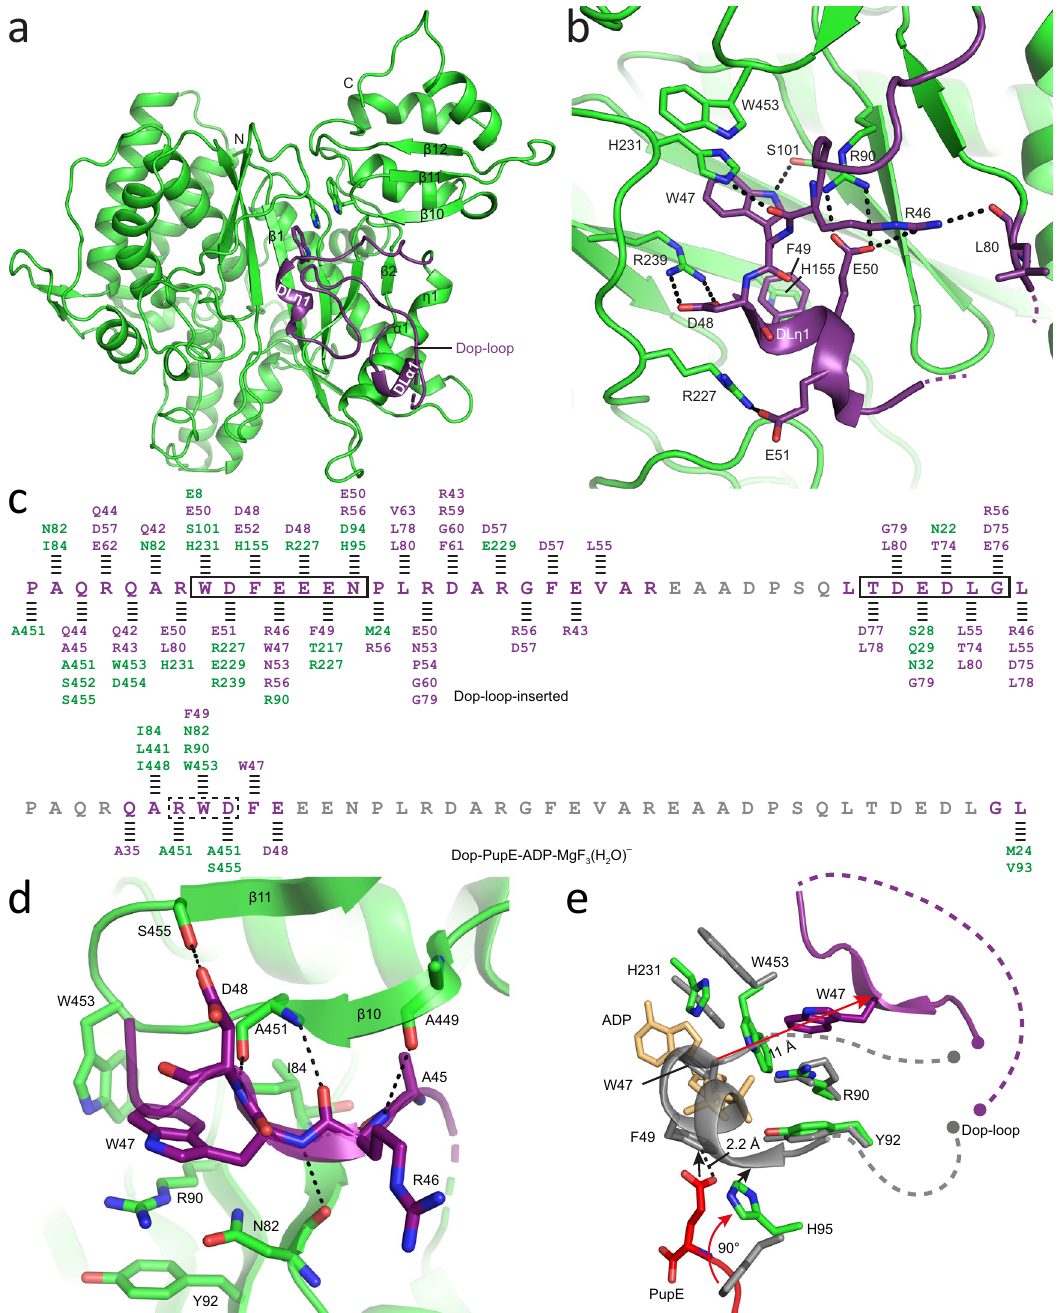
Fig. 2 Interplay between Pup-binding and the Dop-loop conformation. a Crystal structure of Dop with the Dop-loop inserted into the empty active site. Dop is colored green except for the Dop-loop that is colored purple. The unresolved 7-residue stretch of the Dop-loop is depicted as a purple dashed line. b Close-up of the molecular interactions mediated by the fi rst helix (DL η 1) of the Dop-loop. Polar interactions are represented as black dashed lines. c Comparison of the interactions mediated by the Dop-loop in different conformations. Sequence of the Dop-loop in the resolved region is colored purple while for the disordered part it is colored gray. The regions forming helices or β -strands were outlined as solid or dashed black boxes, respectively. Interactions between Dop (green) and the Dop-loop (purple) are indicated as black dashed lines, including hydrogen bonds, hydrophobic and electrostatic interactions assigned with a distance cut-off of 4 Å. d Zoomed-in view of the interactions between the resolved Dop-loop region (purple) and Dop (green) as observed in all Pup-bound structures in this study (here shown on the example of the Dop-PupE-ADP-MgF 3 (H 2 O) − structure). Polar interactions are represented as black dashed lines. e Structural comparison of active site residues as observed in the Dop-loop-inserted structure (gray) and a Pup-bound Dop structure (shown on the example of the Dop-PupE-ADP-MgF 3 (H 2 O) − complex) (green, red, light-orange and purple). Red arrows indicate the movements induced by Pup-binding, while black arrows suggest strong steric clashes. The unresolved or omitted parts of the Dop-loop were depicted as dashed lines (gray or purple) with the ends of the loop represented as fi lled